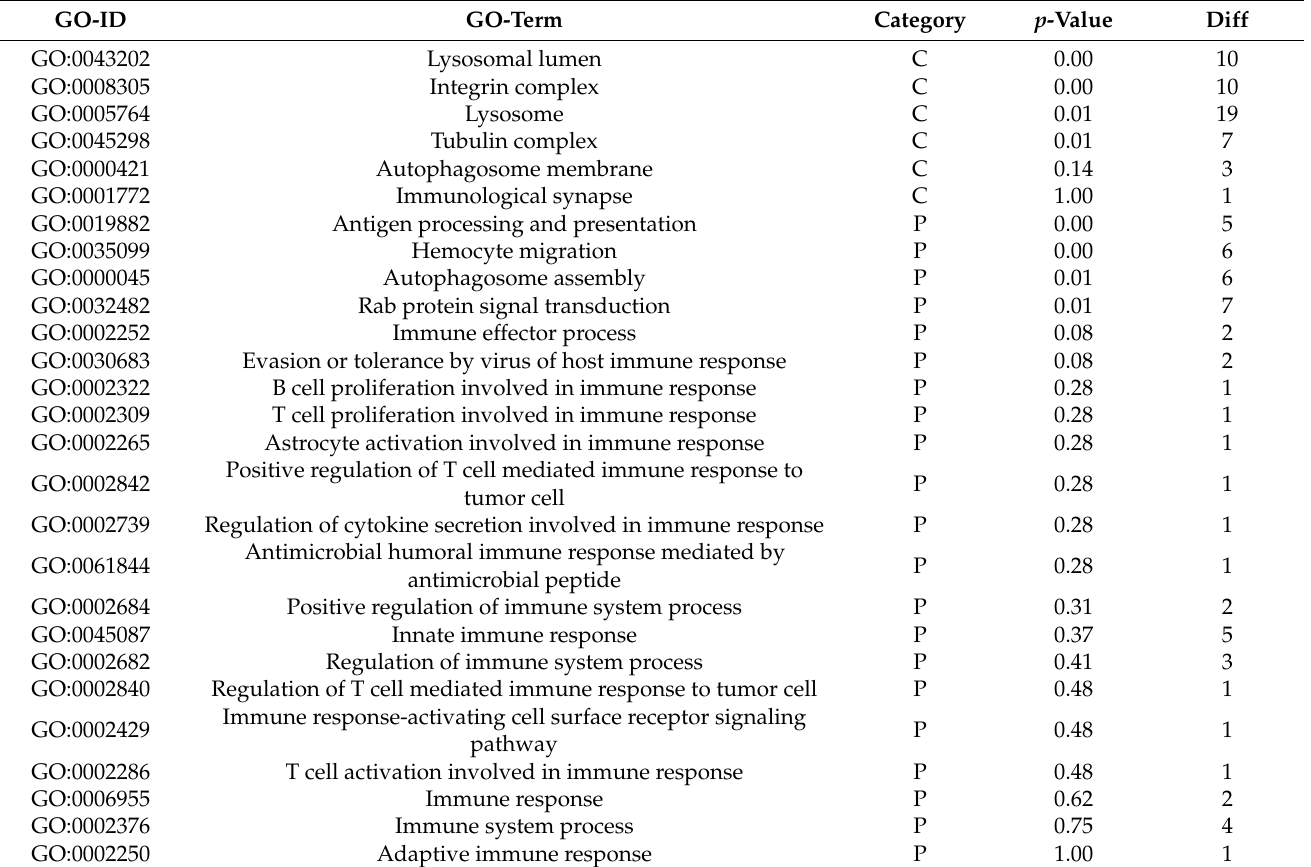
Table 3. Enrichment of GO terms related to innate immune response in the Chinese mitten crab infected with P. gregaria .